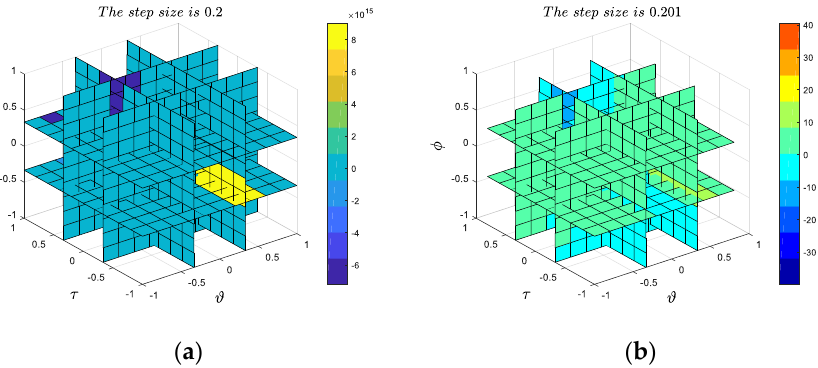
Figure 1. ( a ) The symmetric catastrophe function selects every 0.2 steps to calculate the four-dimensional graph; ( b ) the symmetric catastrophe function selects every 0.201 steps to calculate the four-dimensional graph.